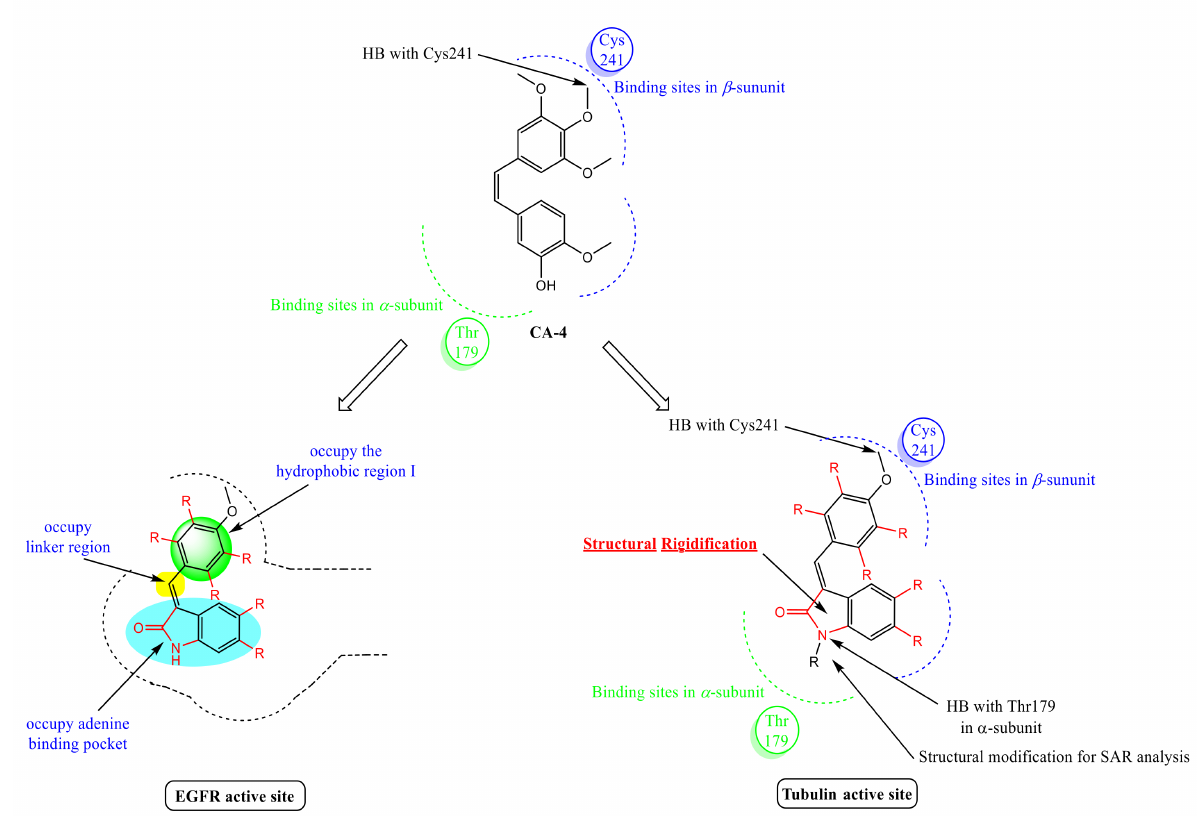
Figure 3. Design of 3-benzylideneindolin-2-one derivatives as tubulin polymerization and protein kinase inhibitors, and their potential binding to tubulin and EGFR kinase active sites. Dotted lines represent active site outline while solid arrows refer to the design